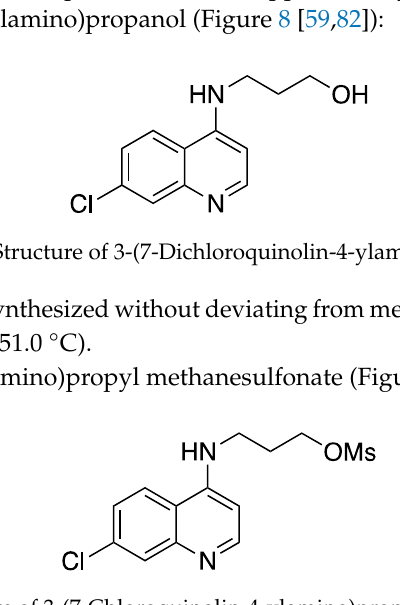
Figure 9. Structure of 3-(7-Chloroquinolin-4-ylamino)propyl methanesulfonate.